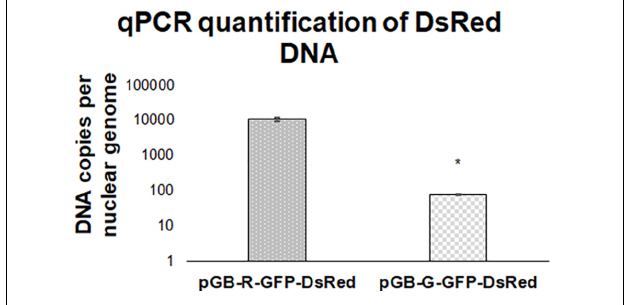
FIGURE 4 | qPCR estimation of the number of vector DNA copies per plant nuclear genome. The plant extracts inoculated with replicating pGB-R-GFP-DsRed construct contain approximately 140 times more copies of DsRed DNA than the extracts inoculated with analogous non-replicating pGB-G-GFP-DsRed construct. Samples were collected at 5 DPI. The graph shows values obtained from one representative biological replicate. Statistically significant differences at p = 0.05 are marked by an